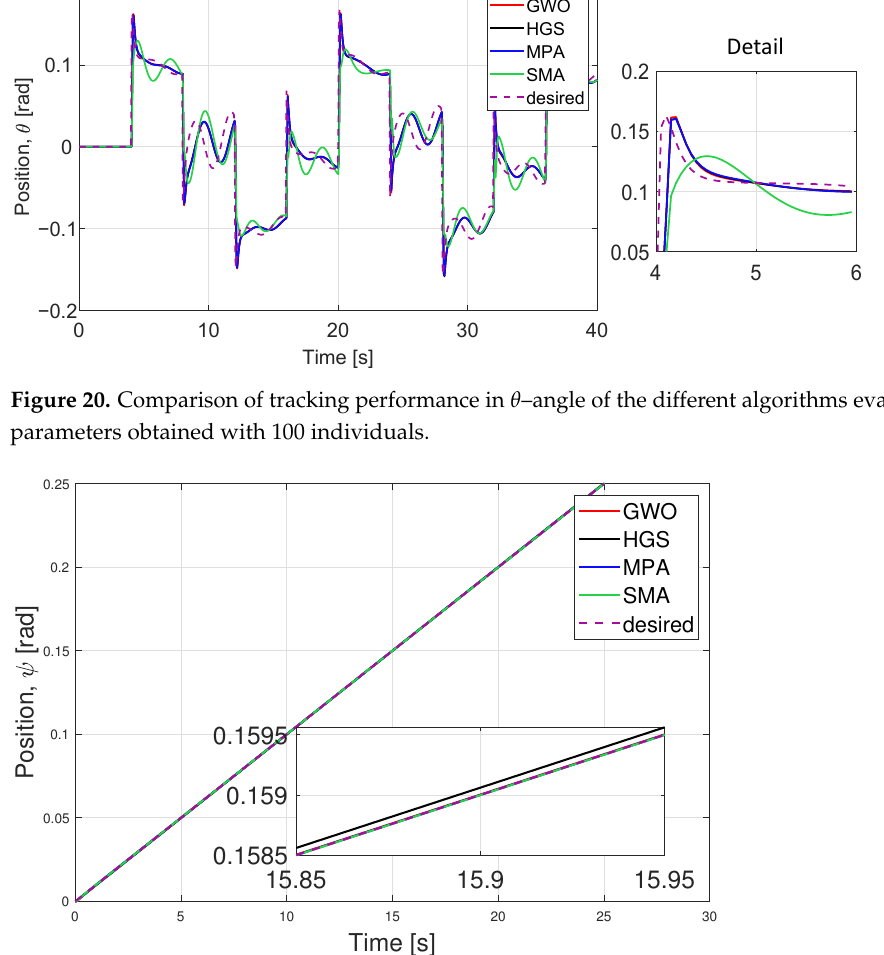
Figure 21. Comparison of tracking performance in ψ –angle of the different algorithms evaluating the parameters obtained with 100